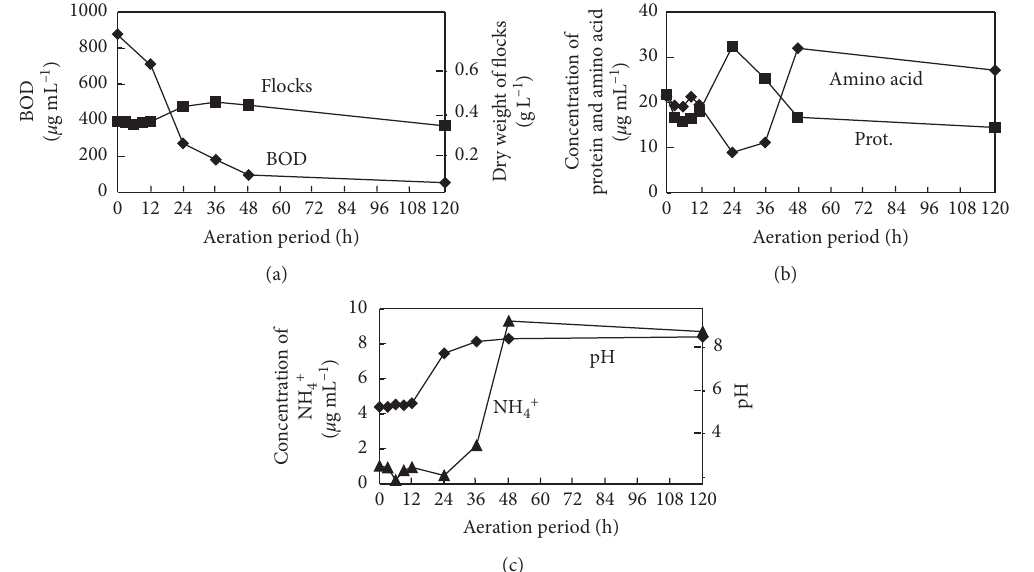
Figure 4: Changes of various parameters in the wastewater during incubation with active sludge in the plastic tank. 50L of the wastewater from a bean curd factory was mixed with 1L of active sludge and aerated as described in Section 2.1. (a) Flocs ( ) and BOD ( ), (b) amino acid ( ) and protein ( ), and (c) NH 4+ ( ) and pH ( ) were measured. Although not all parameters were always tested, the experiment was repeated several times as described in Figure 1. For the details about the method to determine the various parameters, see Section